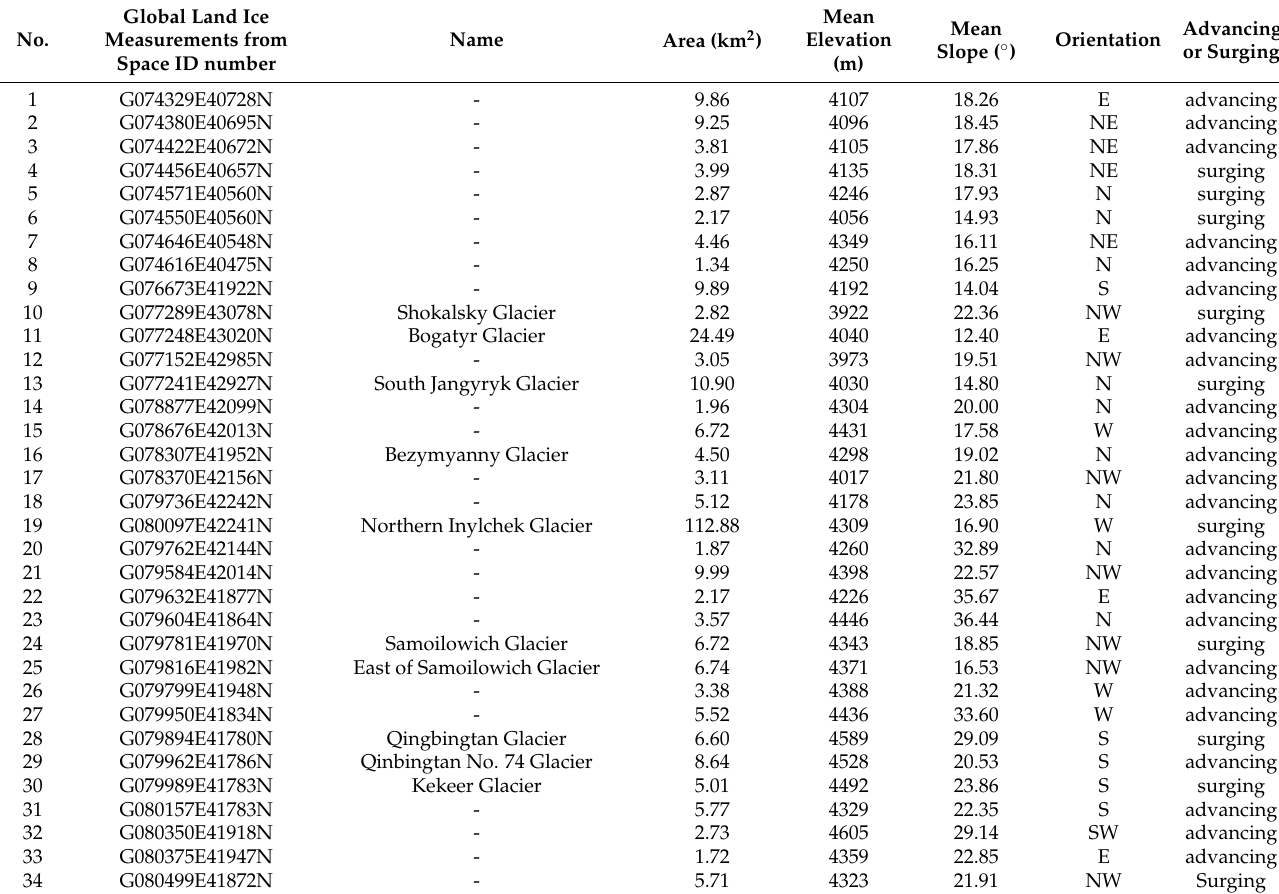
Table 1. Basic parameters of advancing and surging glaciers in the Tien Shan Range (calculated from Randolph Glacier Inventory V6.0; advancing and surging